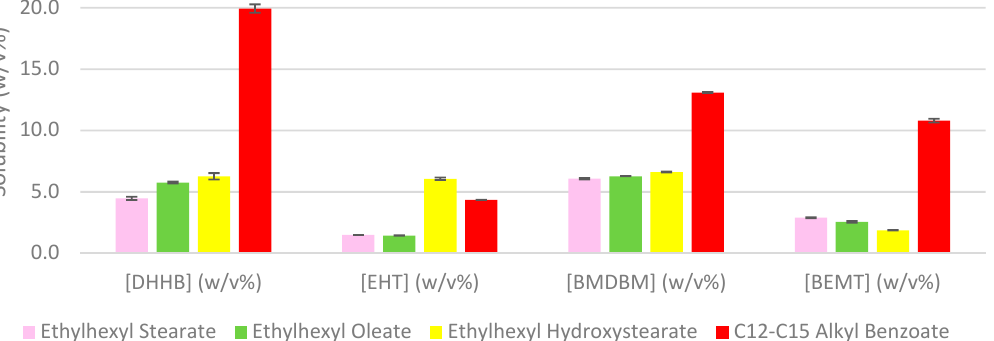
Figure 3. UV filter solubility of different emollients with similar scaffold .